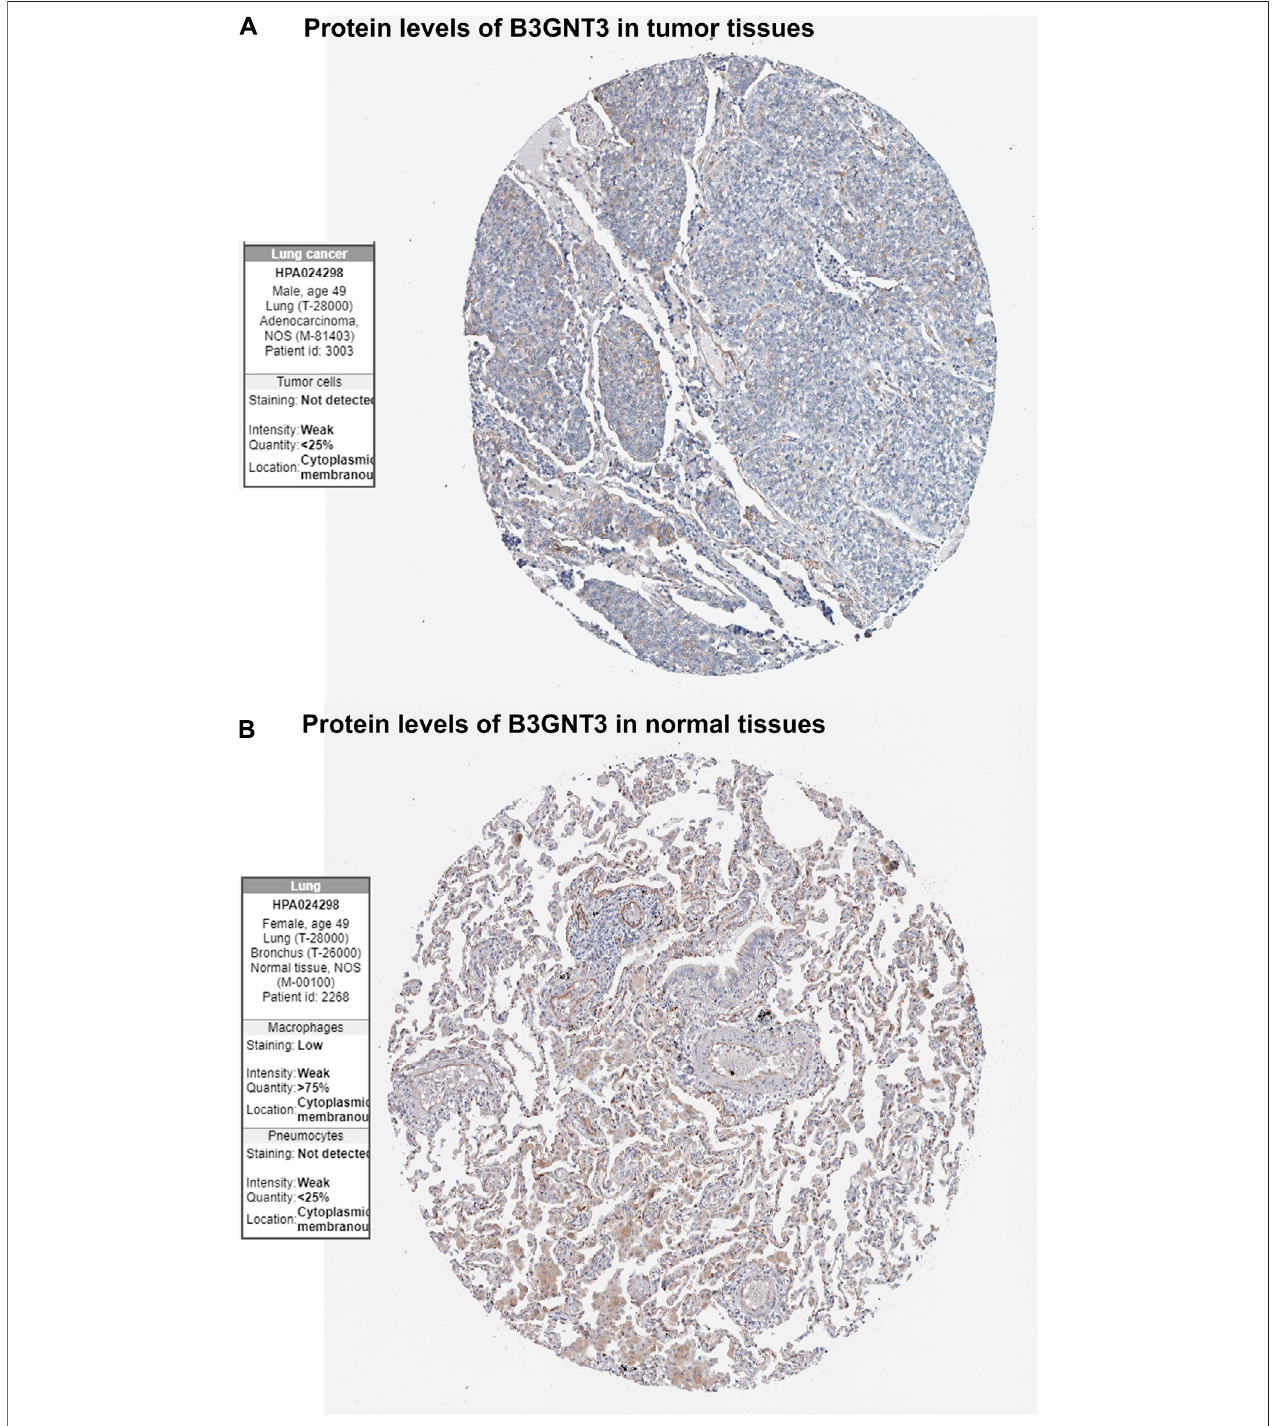
FIGURE7| ImmunohistochemistryoftheB3GNT3geneinLUADandnormaltissuesfromtheHumanProteinAtlas(HPA)database. (A) ProteinlevelsofB3GNT3in LUAD tissues. (B) Protein levels of B3GNT3 in normal lung tissues.